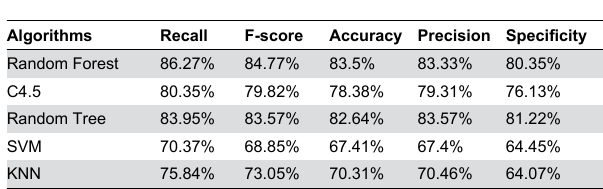
Table 5. Performance of DTM approach after 10-fold cross- validation of algorithms using entire set C and sentences with single patterns only form set C after the named entity recognition.